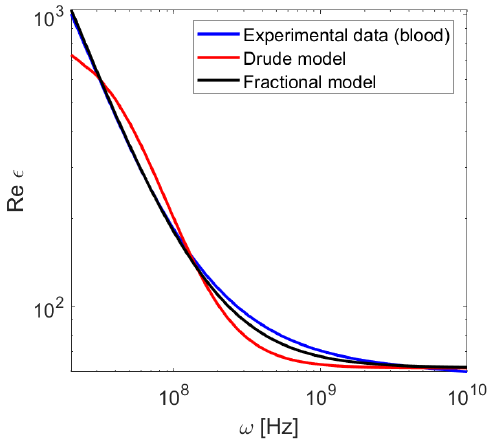
Figure 5. Dielectric susceptibility of blood as a function of